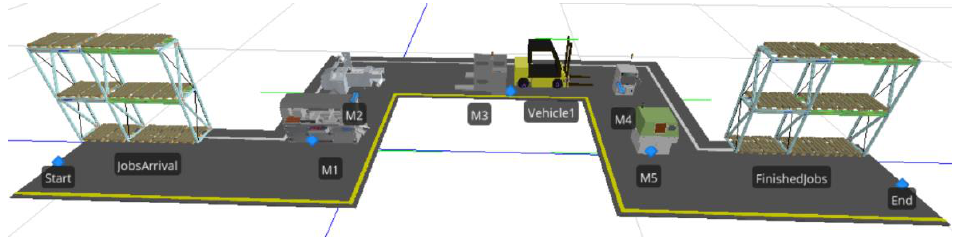
Figure 6. The simulation model in Simio.